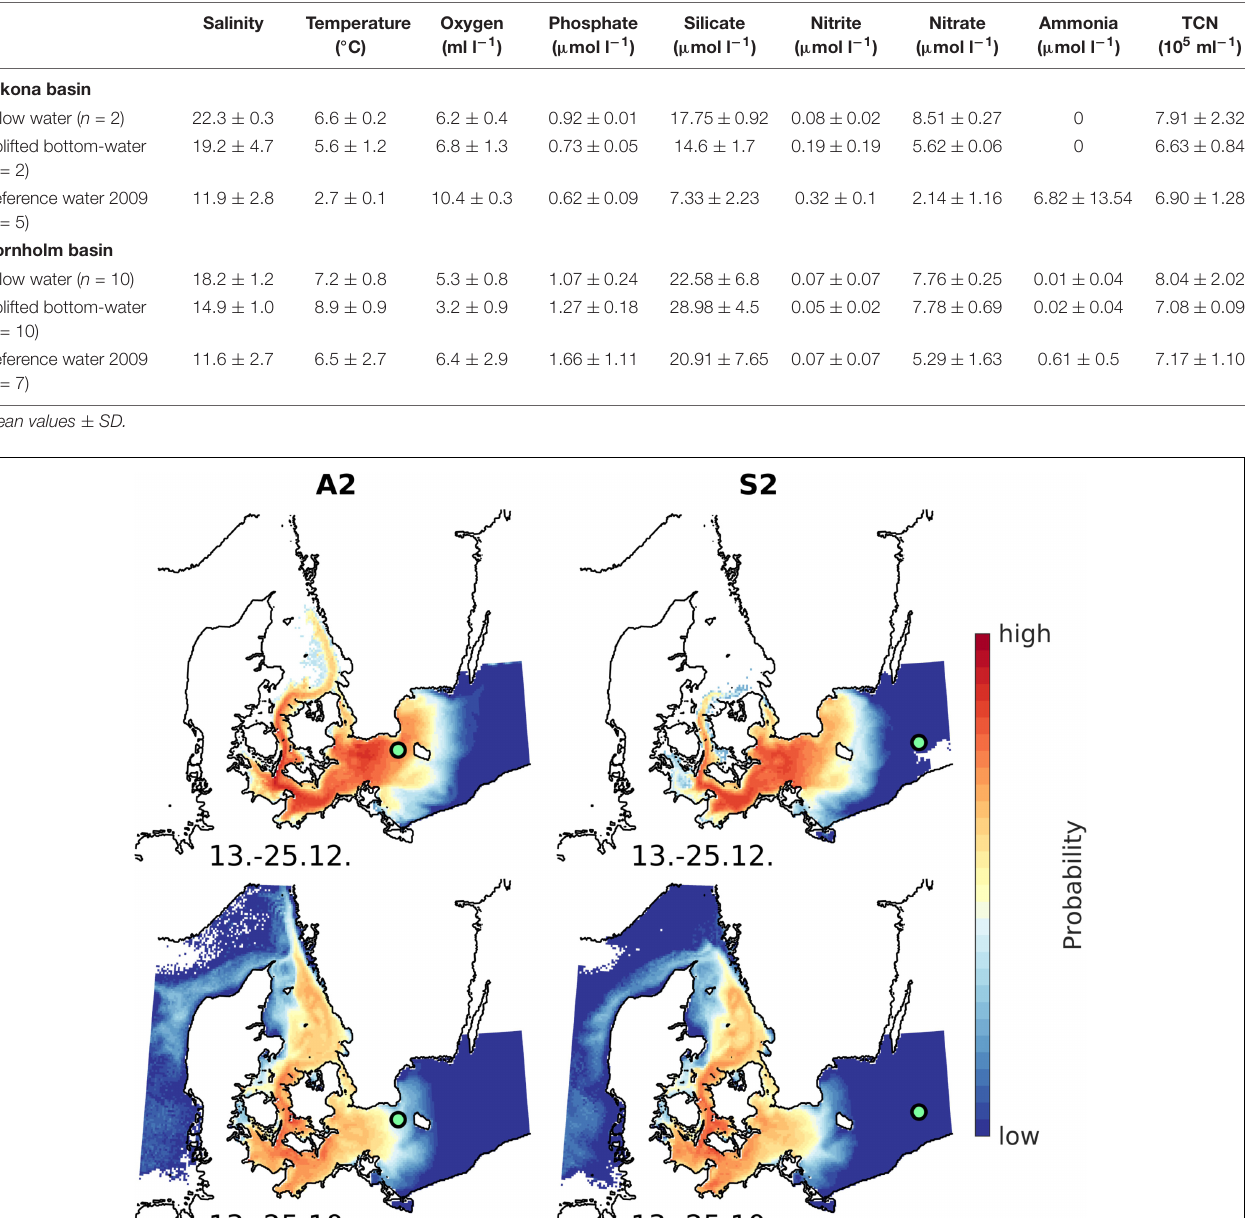
TABLE 1 | Physicochemical parameters and total prokaryotic cell numbers (TCN) in the different water masses in the Arkona and Bornholm Basins.